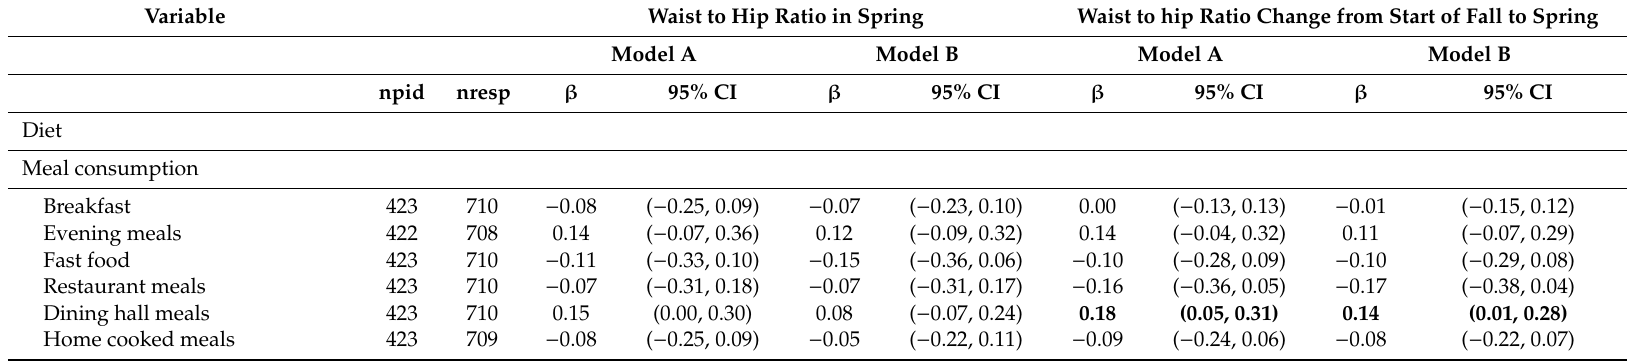
Table 6. Results of the longitudinal linear mixed e ff ect models examining if students’ survey responses on weight-related behavioral factors were associated with their waist to hip ratio, or waist to hip ratio change B